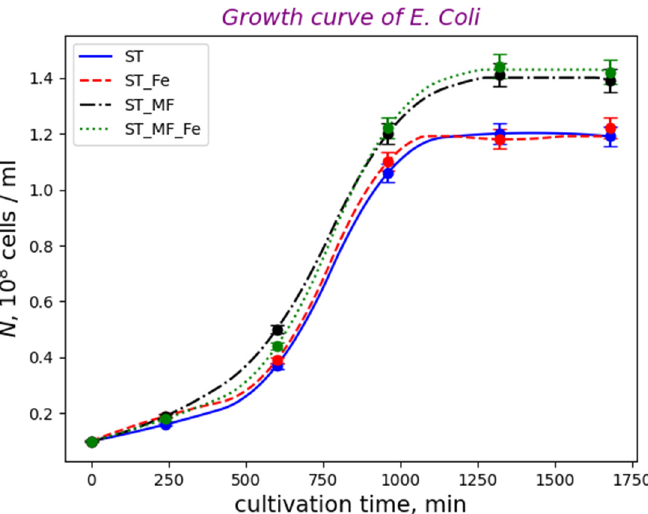
Figure 12. Growth curves of E. coli Nissle 1917 cultivated under different conditions: ST—standard medium (control), ST + Fe—standard medium with iron chelates, ST + MF—standard medium in the gradient 0.15 T MF, and ST + MF + Fe—standard medium with iron chelates in the gradient 0.15 T MF ( p < 0.05). Here, N is the number of cell clusters per ml of cell suspension.